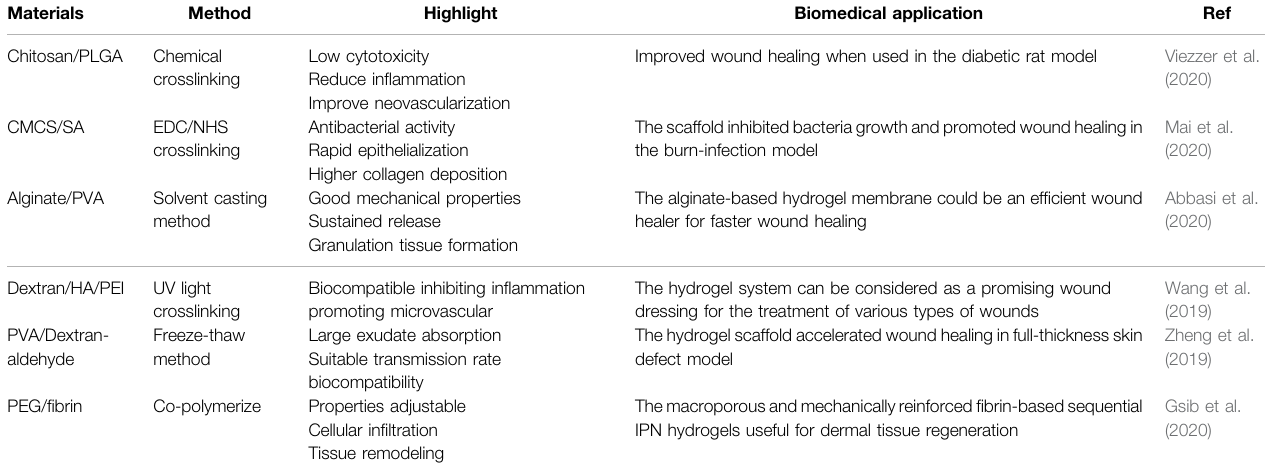
TABLE 3 | Natural-synthetic hybrid materials of bioengineered scaffolds.